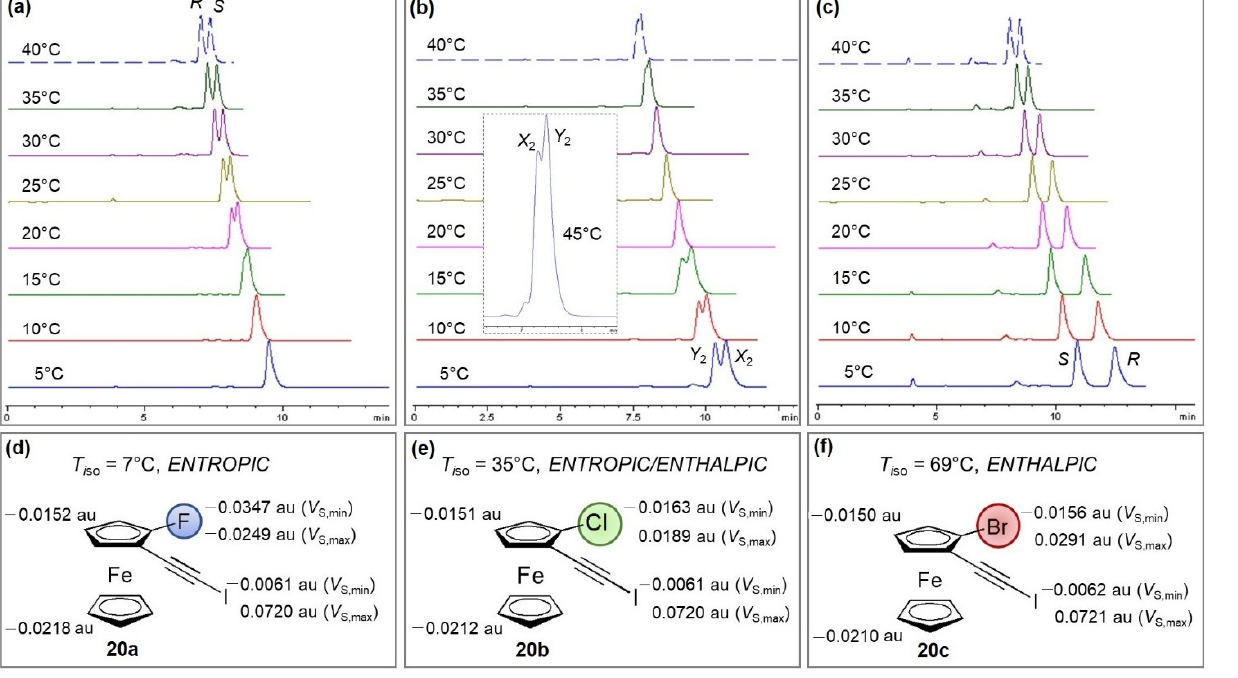
Figure 10. Enantioseparation of ferrocenes 20a ( a ), 20b ( b ) and 20c ( c ) at variable temperatures on a CDMPC-based chiral column with n -hexane/2-PrOH 95:5 v / v as mobile phase and variation of the V S,min and V S,max values (au, atomic unit) ( d – f ) as the 1-halogen substituent changes in the series of 1-halo-2-(iodoethynyl)ferrocenes 20a – c (Reprinted/adapted with permission from Ref. [67]. Copyright 2022, Elsevier).